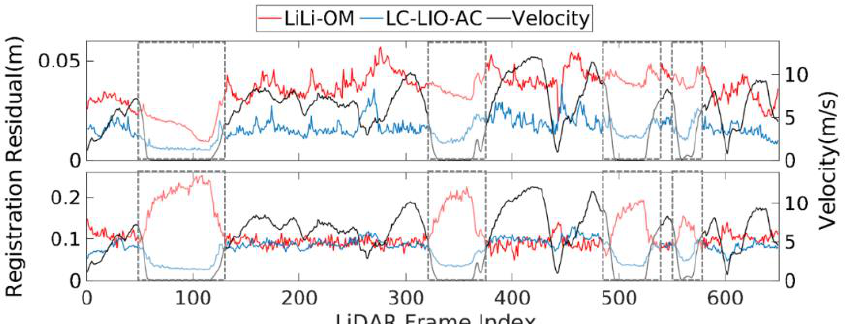
Figure 15. The final LiDAR scan-to-map registration residual of feature points after the registration converges on each frame of LiLi-OM and LC-LIO-AC that are corresponding in time in the urban canyon 2. The black line represents the velocity of these frames calculated by LC-LIO-AC. The segments in gray boxes represent when the vehicle stop for a while and the velocity is zero. The top and bottom panels represent the residual for plane and edge points, respectively.